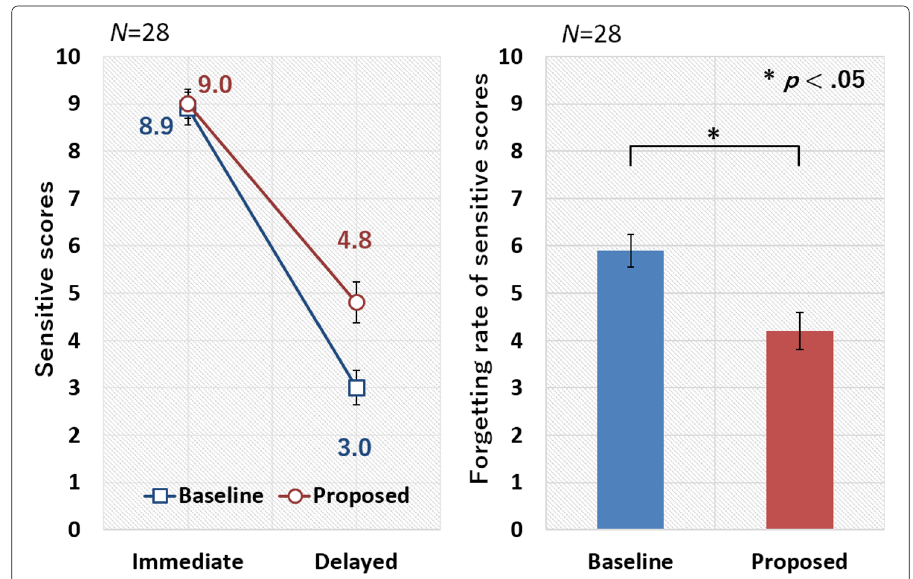
Fig. 9 Left: Average sensitive scores for the immediate and delayed tests. Right: Forgetting rate of this score under the baseline and proposed methods. The error bar means standard error